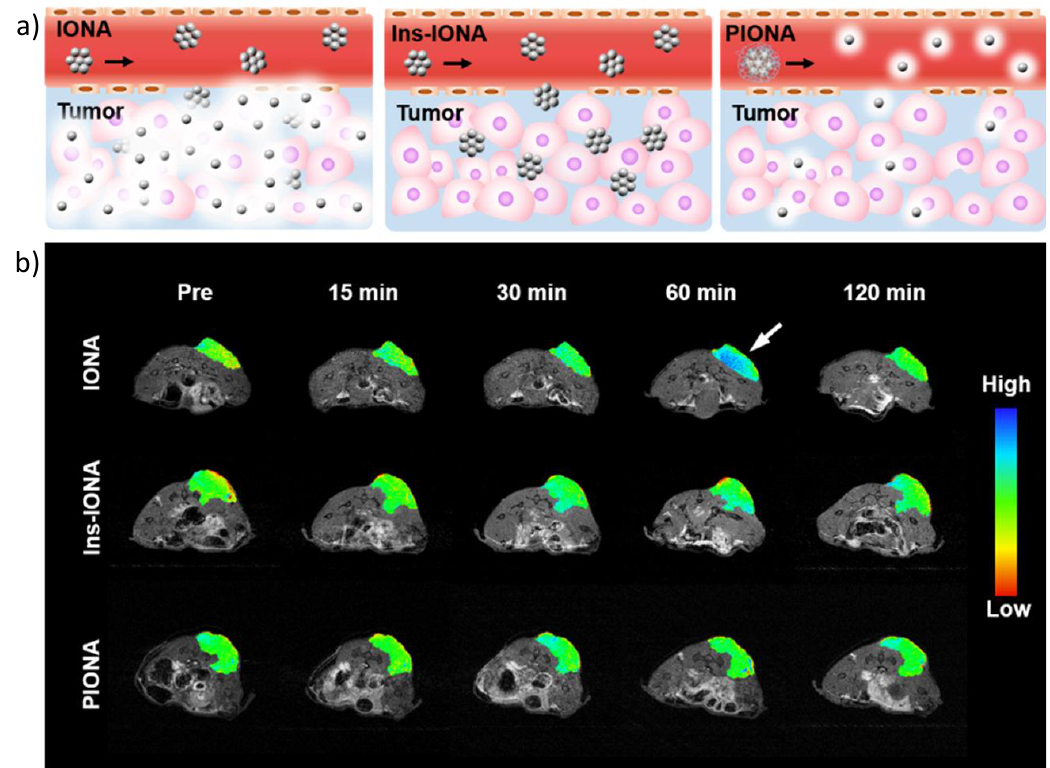
Figure 3. ( a ) Schematic illustration of the structural changes of iron oxide nanoparticle assemblies (IONAs) , Ins−IONAs and polymer-assisted IONAs (PIONAs) in blood flow. The IONAs and Ins−IONAs are stable in blood circulation. After accumulation in tumour, IONAs further disassemble into dispersed ESIONs for non-linear amplification of MR imaging, while Ins−IONAs remain in the quenched T 1 MR state. PIONAs gradually dissociate during the blood circulation even before their accumulation in tumour. ( b ) T 1 -weighted MR images of tumour-bearing mice before and after i.v. injection of IONAs, Ins−IONAs and PIONAs. Modified and reproduced with permission from [88], published by ACS, 2019.